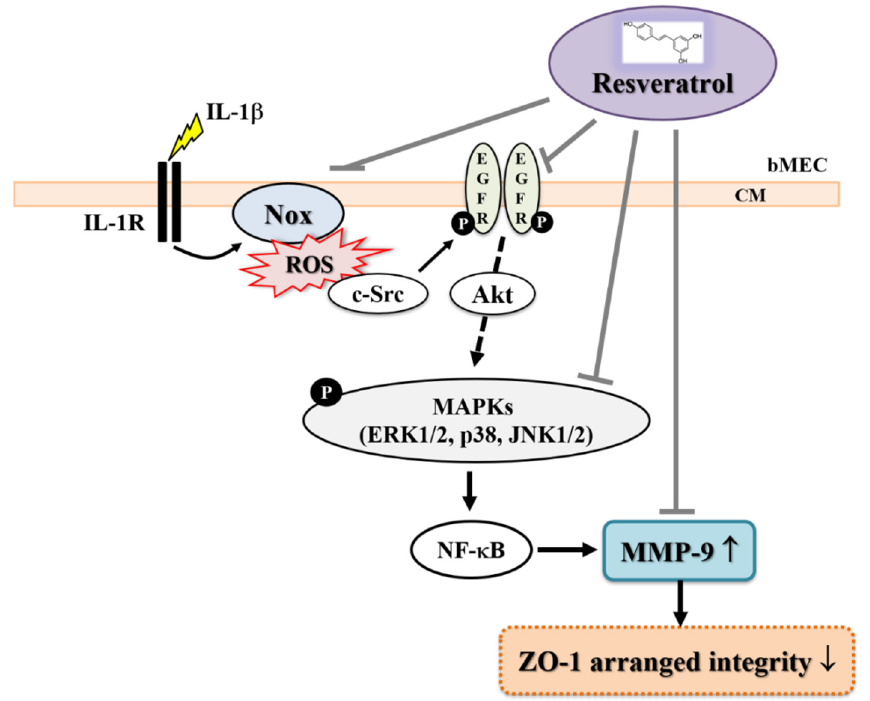
Figure 7. Schematic presentation of the effects of resveratrol on the IL-1 β -induced upregulation of MMP-9 and disruption of ZO-1 arranged integrity in bEnd.3 cells. In brain microvascular endothelial cells (bEnd.3 cells), IL-1 β induces MAPKs (i.e., ERK1/2, p38, and JNK1/2) activation through Nox-derived ROS signal and c-Src-mediated transactivation of EGFR pathways, resulting in NF- κ B- dependent MMP-9 expression. The raised MMP-9 (MMP-9 ↑ ) causes disruption of ZO-1 arranged integrity (ZO-1 arranged integrity ↓ ). Resveratrol blocks the IL-1 β -induced MMP-9-mediated events (disruption of ZO-1 arranged integrity) via inhibiting activation of Nox/ROS, c-Src-dependent transactivation of EGFR, MAPKs (i.e., ERK1/2, p38, and JNK1/2), and NF- κ B signaling pathways in these